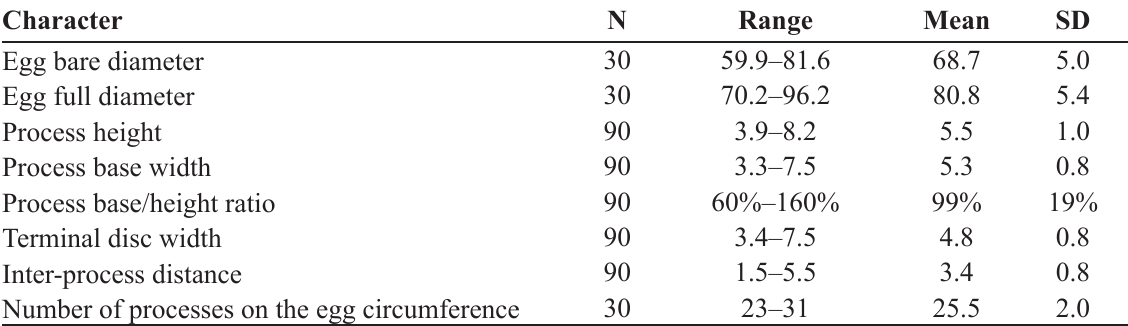
Table 6. Measurements (in µm) of selected morphological structures of the eggs of Macrobiotus canaricus sp. nov. mounted in Hoyer’s medium. (N = number of eggs / structures measured; Range = the smallest and the largest structure among all measured specimens; SD = standard